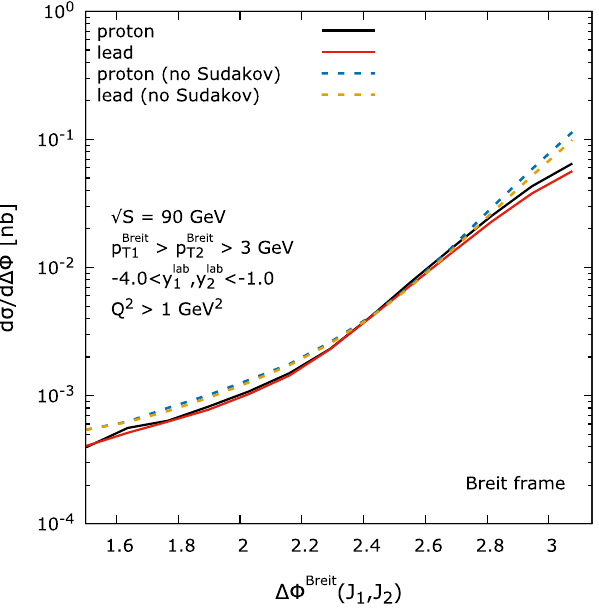
Fig. 5 Azimuthal correlations between the jets in the Breit frame